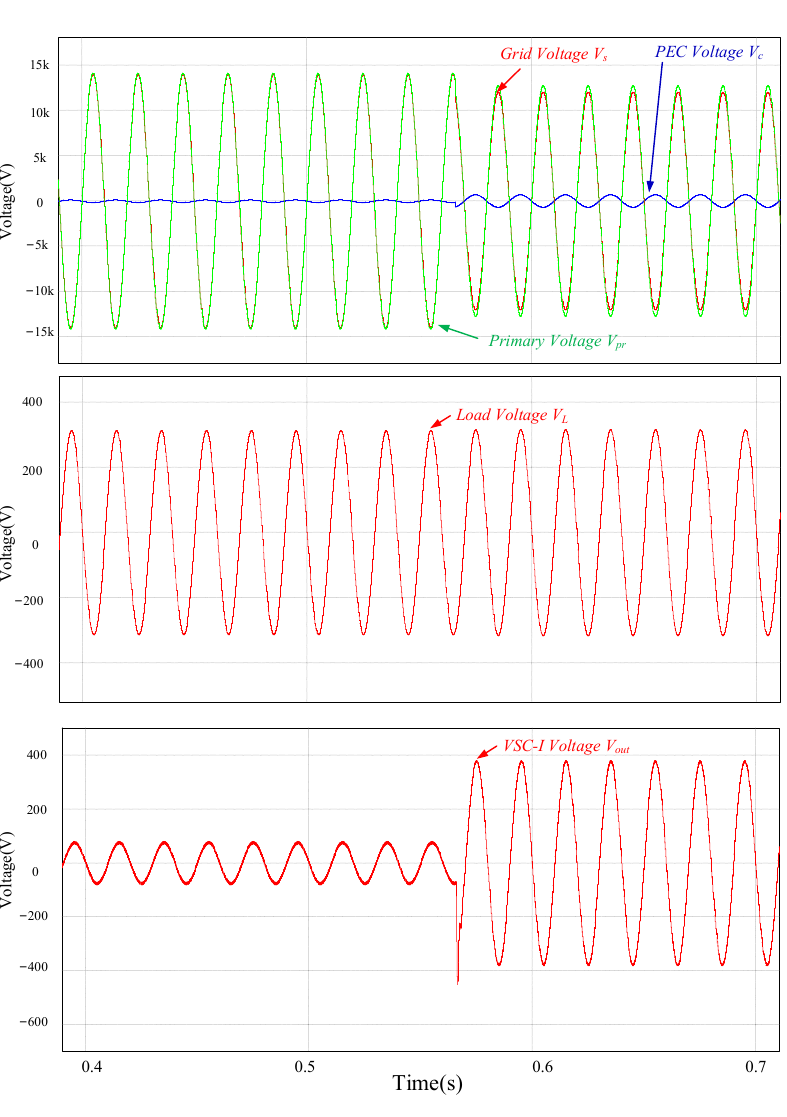
Figure 13. Voltage waveforms during voltage regulation with flexible OLVR.